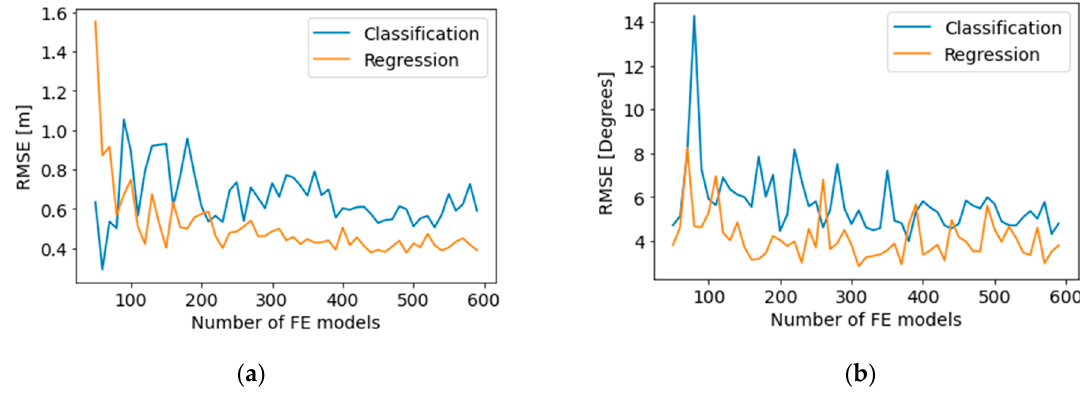
Figure 12. RMSE vs. a number of FE models of ( a ) the vertical excavation problem and ( b ) the inclined slope problem.